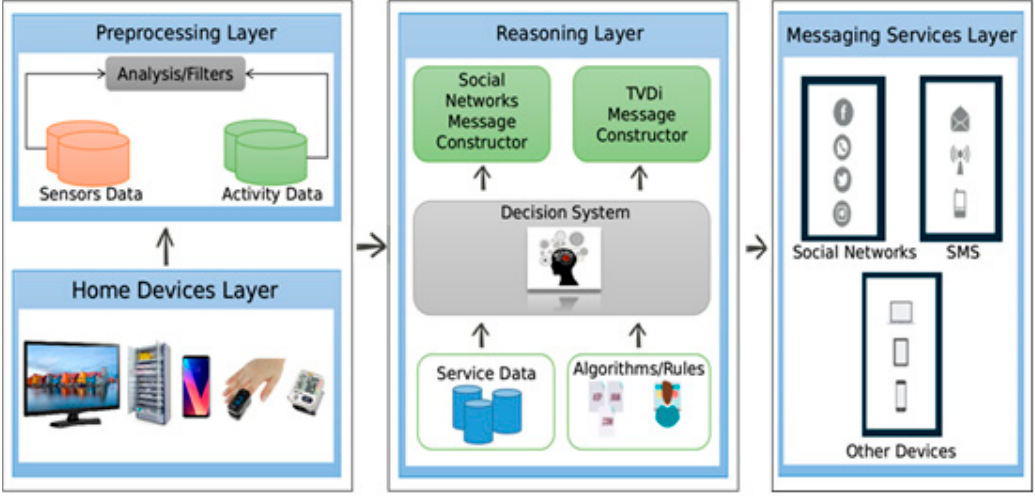
Figure 2. System architecture proposed to process data and send social network messages. There are four layers, which are responsible for data gathering, analysis, decision making, and messaging.